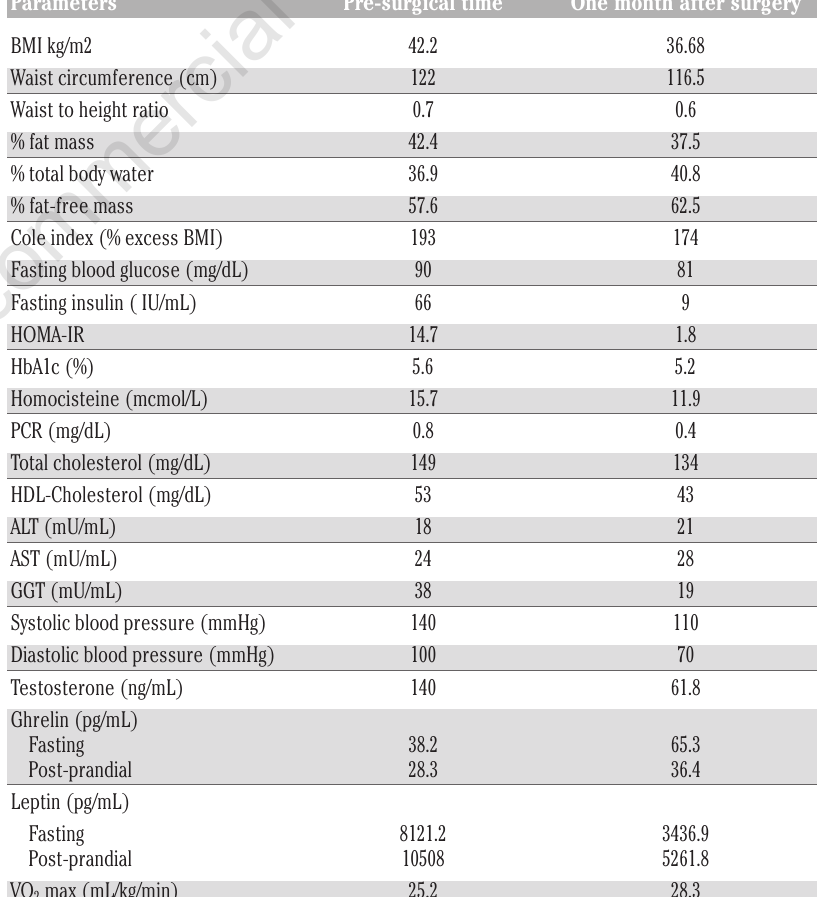
Table 1. Clinical, metabolic and hormonal parameters at the pre and post-surgical